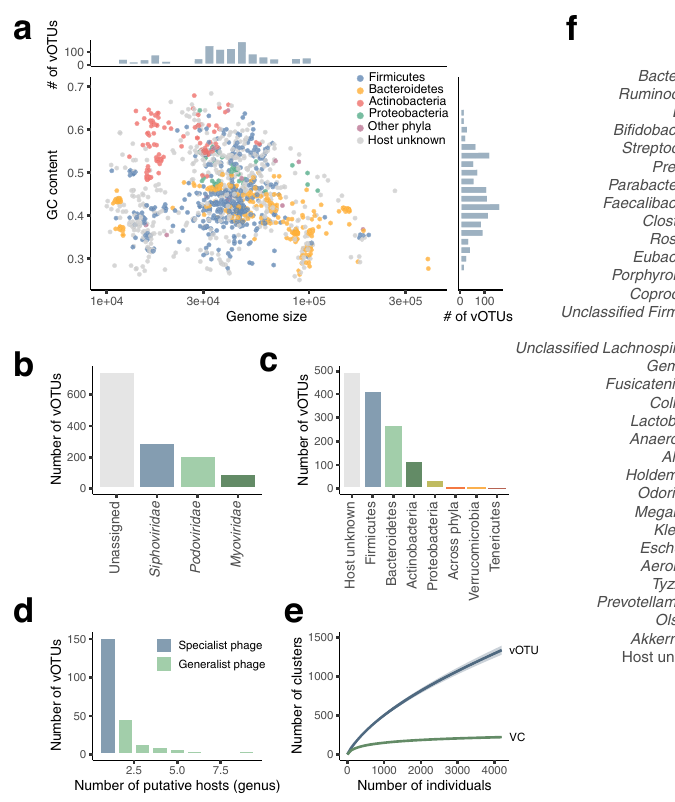
Fig. 1 | Overview of reconstructed phage genomes from 4198 human gut metagenomes. a Genome size and GC content of phage genomes ( n =4709) reconstructed fromthe datasetof 4,198whole metagenomes.Bar plotsonthe top andrightsidedepictthedistributionofgenomesizeandGCcontent,respectively. b Taxonomic annotation of the vOTUs at the family level. c Predicted hosts of the vOTUsatthephylumlevel. d Numberofpredictedhostsatthegenuslevelforeach vOTU. e Rarefaction curves of the detectedvOTUs and VCs (meannumber) inthis cohort ( n =4,198). Shadows of the lines represent 95% con fi dence intervals.